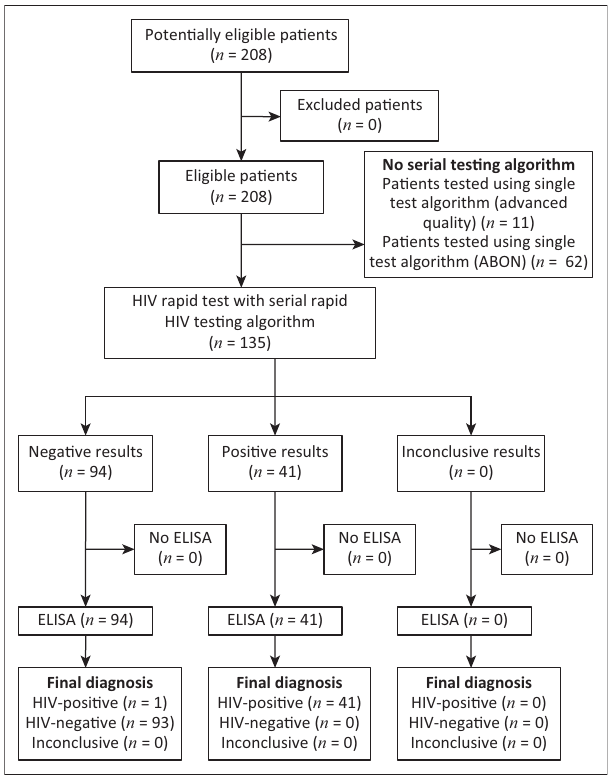
FIGURE 2: Standards for Reporting of Diagnostic Accuracy (STARD) flowchart for accuracy of serial rapid HIV testing algorithm in rural PHC clinics for antenatal patients. TABLE 2: Diagnostic accuracy of human immunodeficiency virus rapid testing among pregnant women attending antenatal clinics in KwaZulu-Natal. Sample